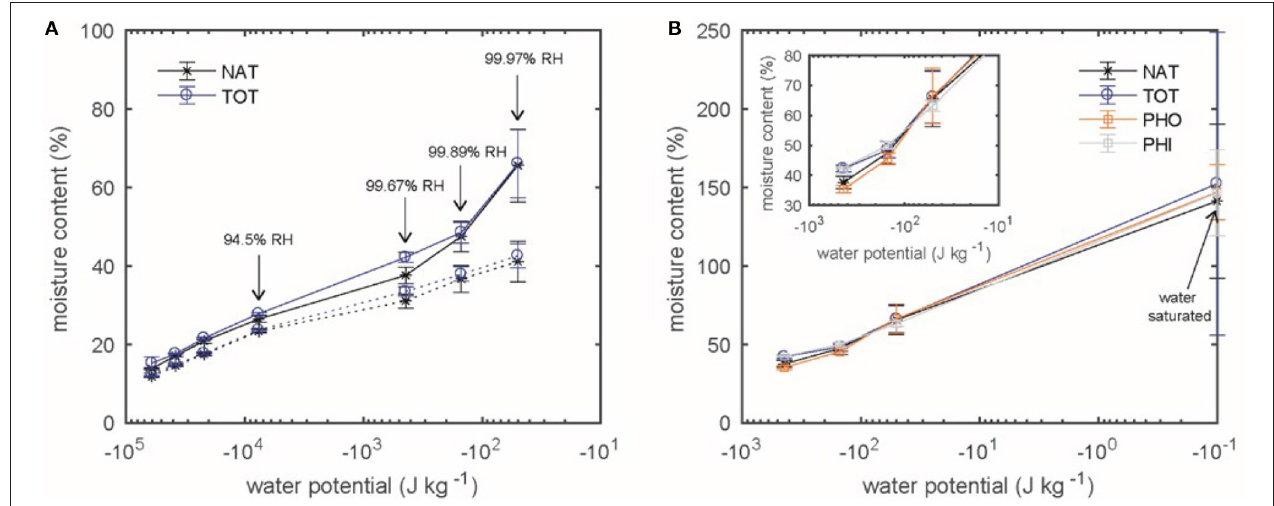
FIGURE 7 | The adjusted MC (according to Equation 3) is plotted as function of water potential for Kurile Larch. (A) The absorption (dotted line) and desorption (solid line) isotherms for native (NAT) and total extracted (TOT) samples is shown. (B) Desorption isotherms in the over-hygroscopic range are shown for native larch (NAT) and after extraction with 2 hydrophobic (PHO), 2 hydrophilic (PHI) or a total of 4 solvents (TOT).